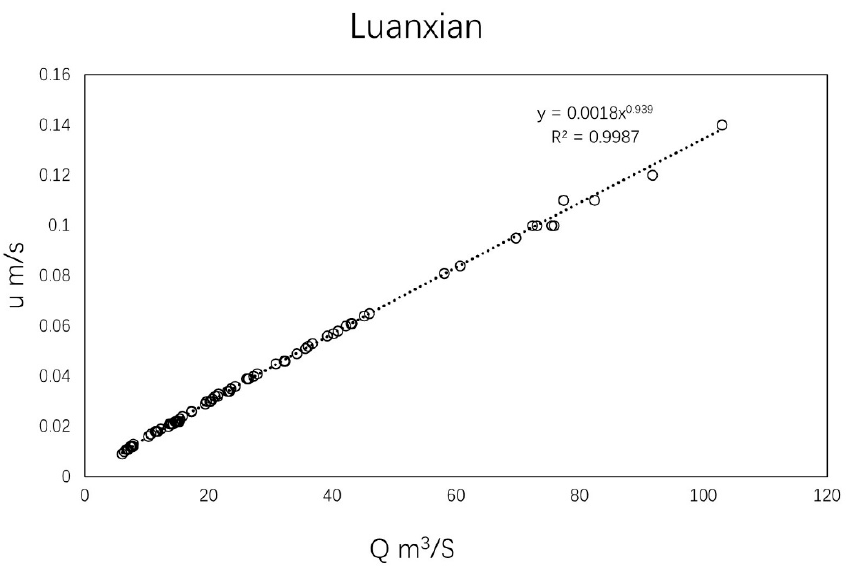
Figure 7. Empirical relationship between flow and velocity in three hydrological gauges of Luanhe mainstream.